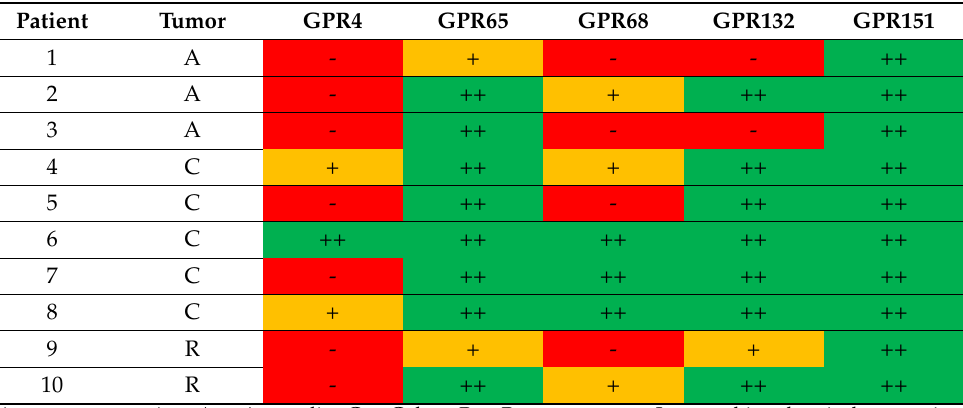
Table 1. Summary of the immunohistochemical staining results for GPR4, GPR65, GPR68, GPR132, and